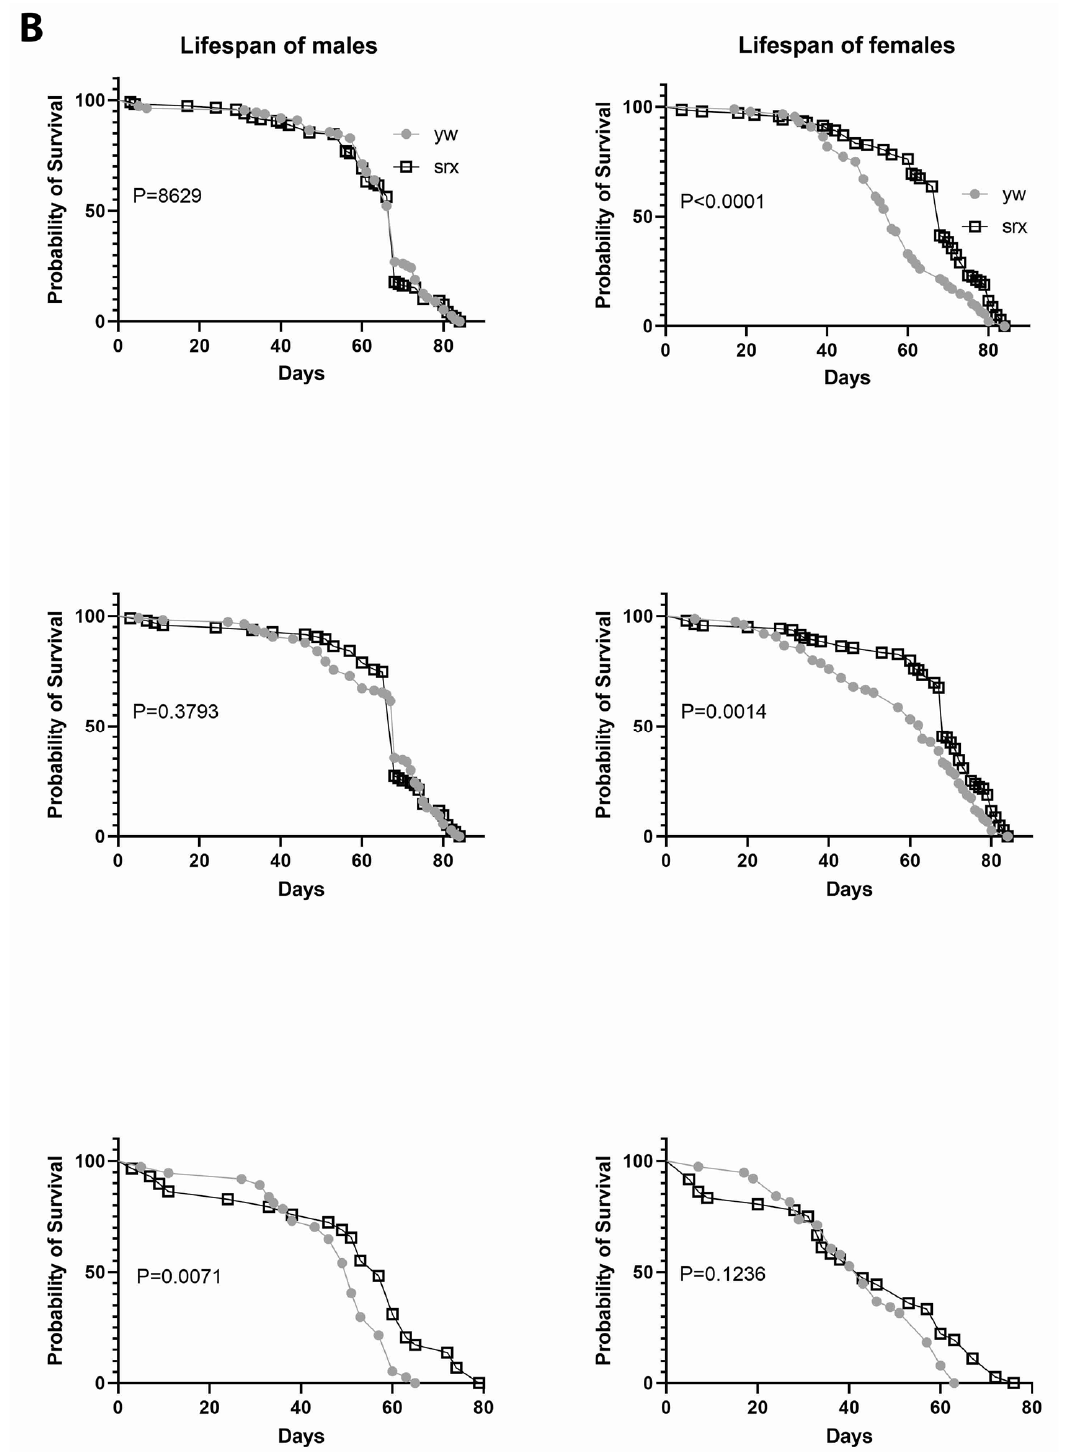
Figure 5. Effects of Srx underexpression on survival under normal and oxidative stress conditions. Control ( yw ) and the srx mutant (srx) flies were fed 1% sucrose solution containing 0.5 M H 2 O 2 ( A ) or reared under normal conditions ( B ). Results were obtained with 3 different biological replicates. Approximately 100–150 flies for each fly line were used in the experiments. Statistically significant differences ( p < 0.05) were determined by the log rank test and p values for each experiment are shown on the graphs. Representative immunoblot images are shown in Figure